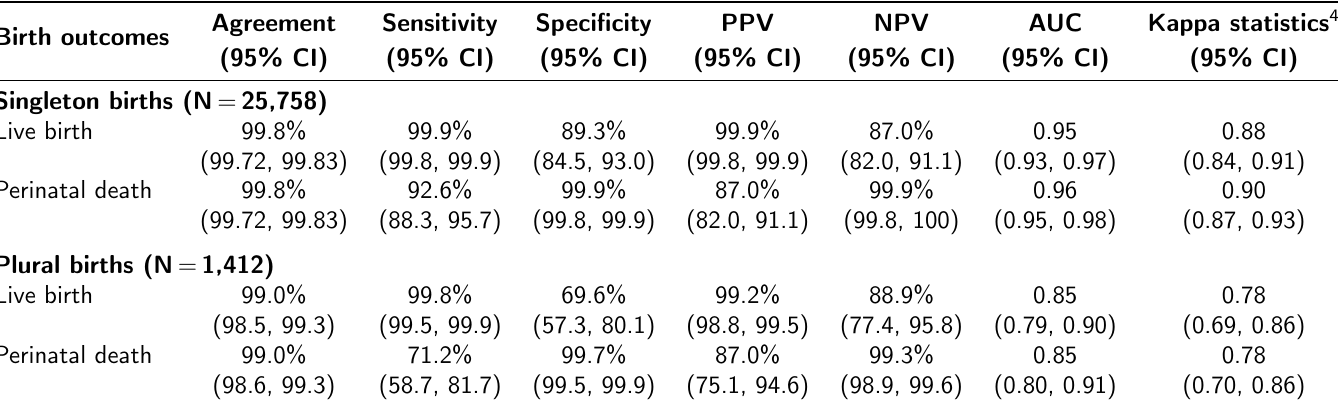
Table 3: Agreement measures of each birth outcome between ANZARD and PDC data 1 , 2 , for New South Wales (NSW) residents 3 , by plurality status Birth